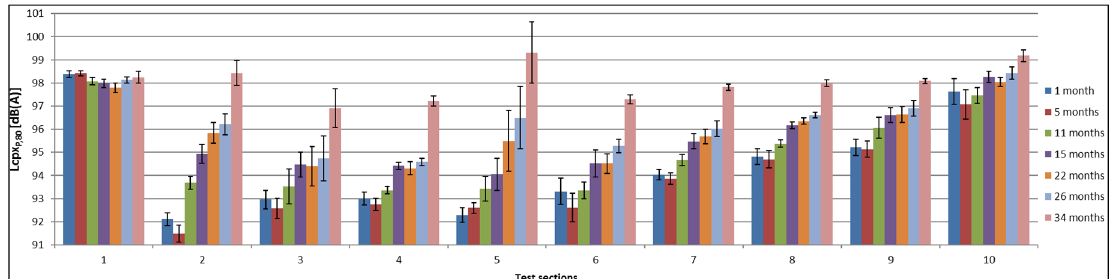
Figure 6. Overview of CPX measurements performed 1, 5, 11, 15, 22, 26 and 34 months after construction with the P1 tire at 80 km/h (with temperature correction).